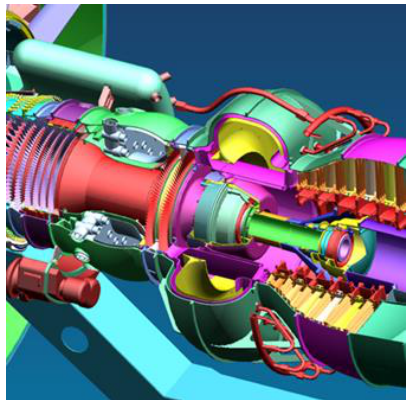
Figure 25. Cross-sectional view of the hybrid engine with two combustion chambers designed in the AHEAD project [38].